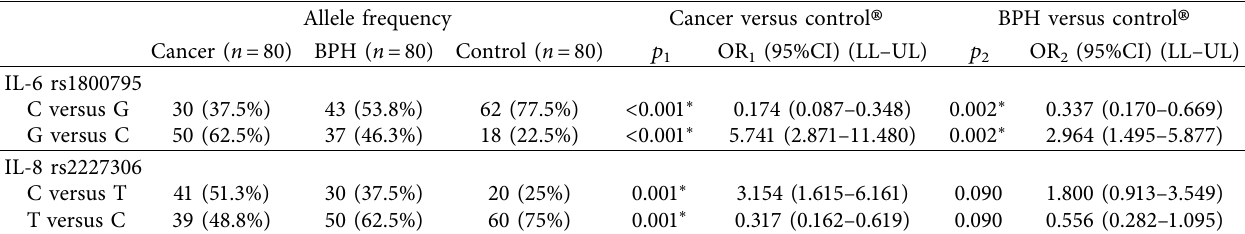
Table 4: Comparison of allele frequencies of IL-6 rs1800795 and IL-8 rs2227306 SNPs in the three studied groups.